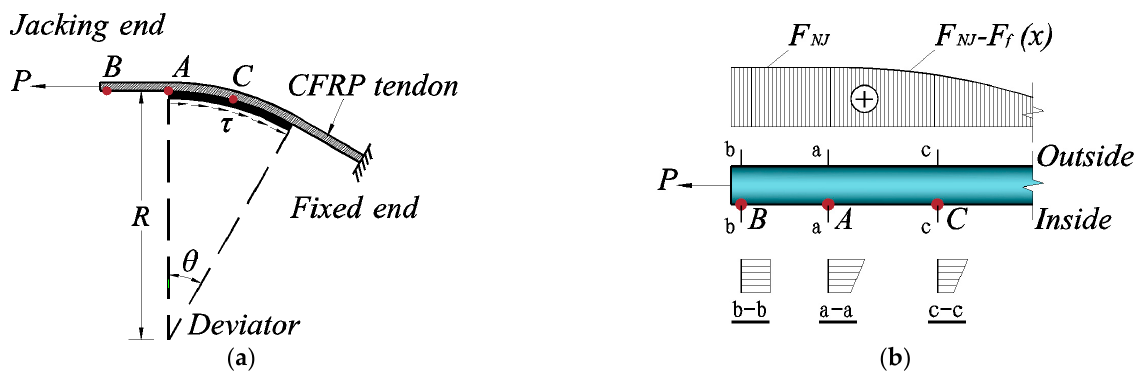
Figure 1. ( a ) Overall force of a single tendon, ( b ) Force of the cross-section of a single tendon. Stress analysis of CFRP tendons under bending.